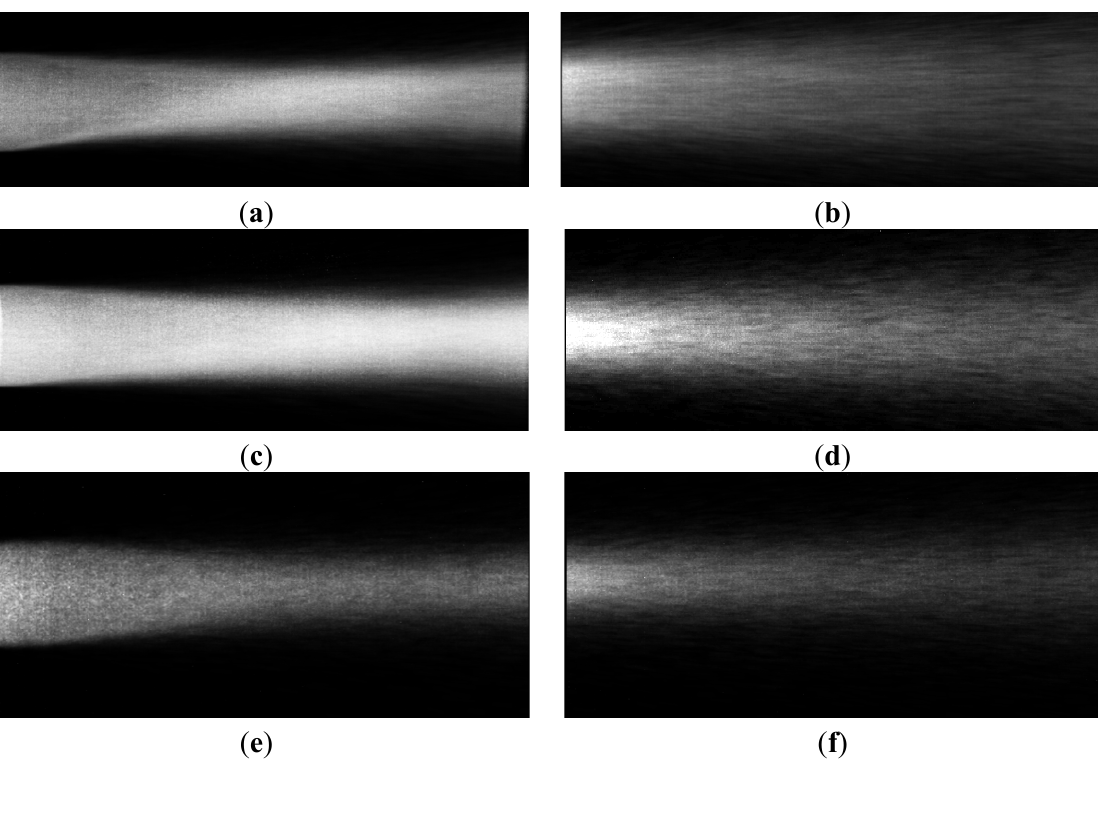
Figure 7. Sum of 712 photos from the tip of the central jet to 50 mm downstream, left images, and from 50 mm downstream to 100 mm downstream, right images. Each image spans 50 mm. Experiment 1: ( a ), ( b ); Experiment 2: ( c ), ( d ); Experiment 3: ( e ), ( f ). Exposure t ime: 100 μ s, except (d ) 200 μ